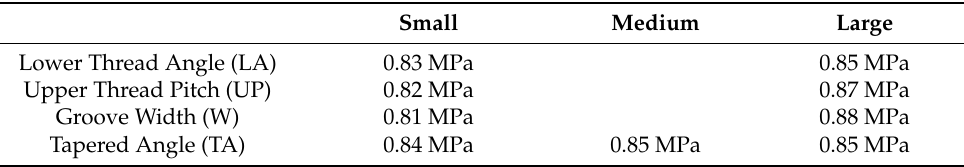
Table 7. Comparison of average stress on the first layer of test block of four different design factors in 10